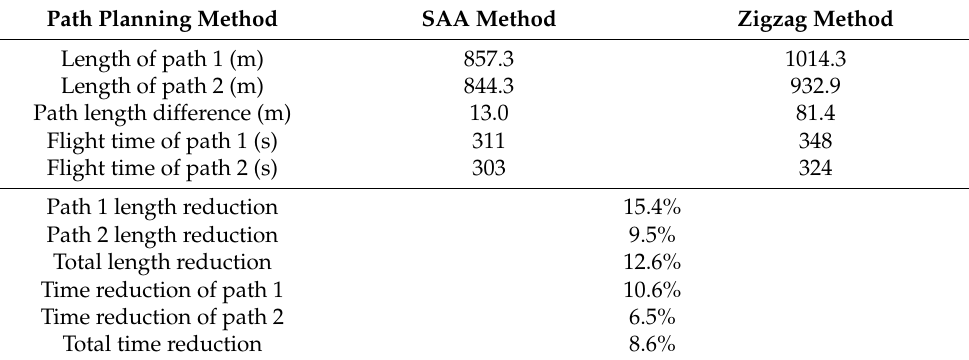
Table 2. Path lengths of the experiments.